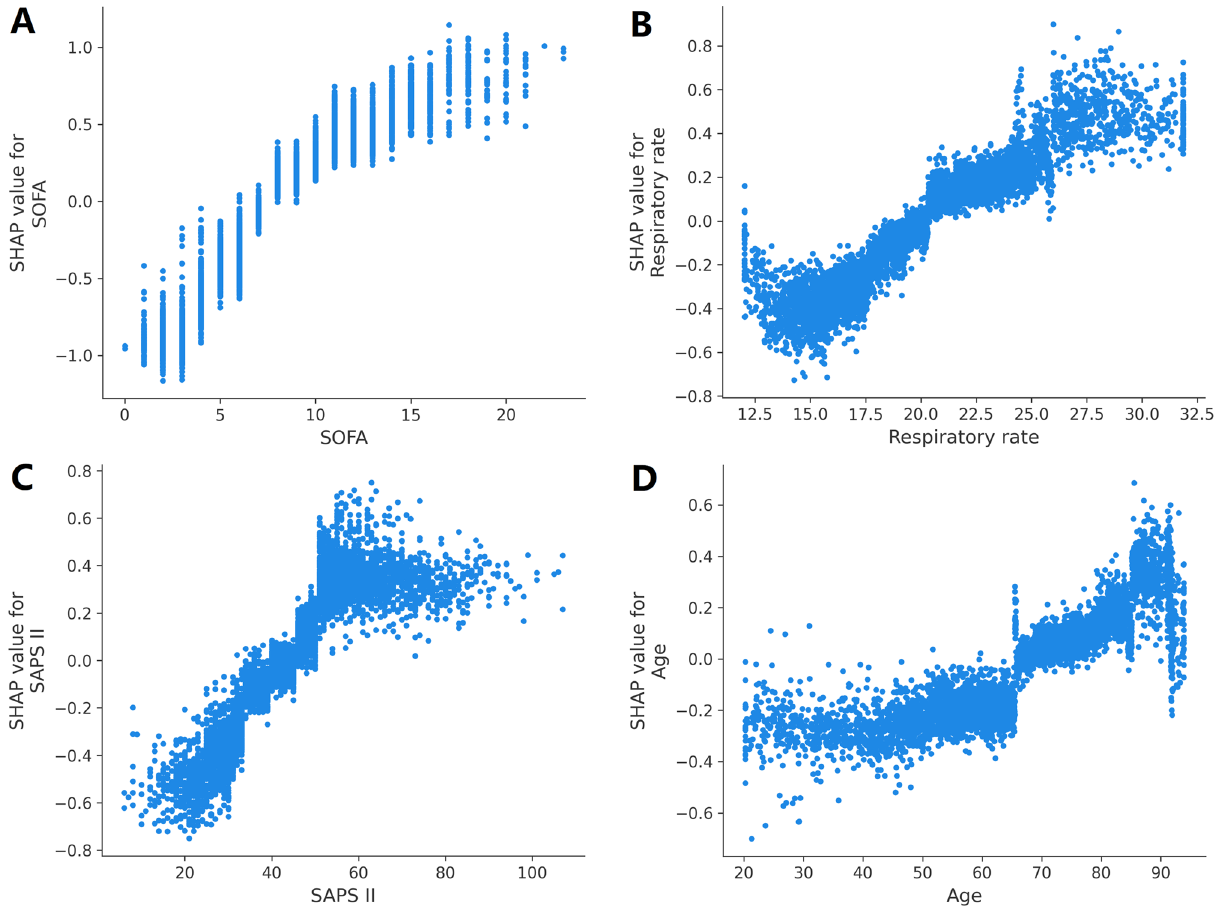
Figure 5. SHAP dependence plot of the XGBoost model. ( A ) SOFA score; ( B ) Respiratory rate; ( C ) SAPS II; ( D ) Age. Certain SHAP levels surpass zero indicates an elevated risk of death. SHAP SHapley additive explanation, SOFA Sequential organ failure assessment, SAPS II Simplified acute physiology score